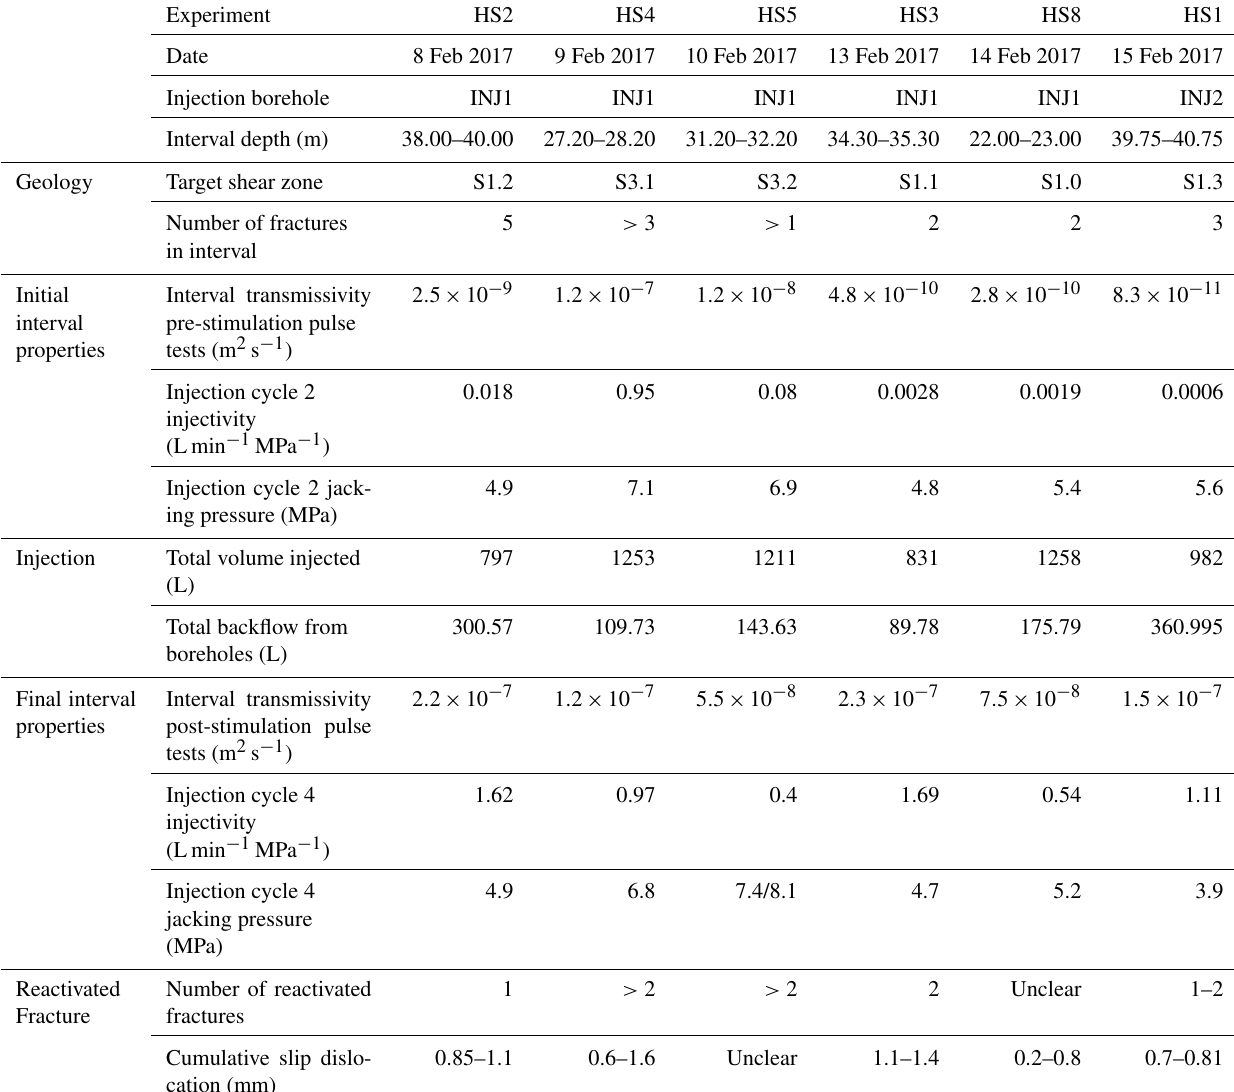
Table 1. Overview of the stimulation experiment with corresponding information about the injection interval in chronological